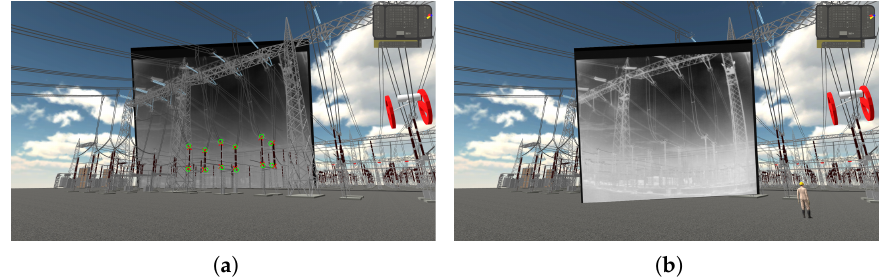
Figure 16. 2D–3D registration for experiment T1: ( a ) custom shader and keypoints; ( b ) overlay.